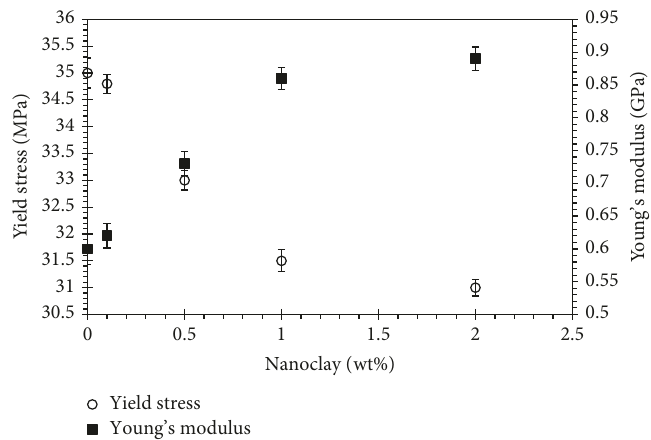
Figure 7: Yield strength and Young’s modulus of neat PP as a function of nanoclay wt%.